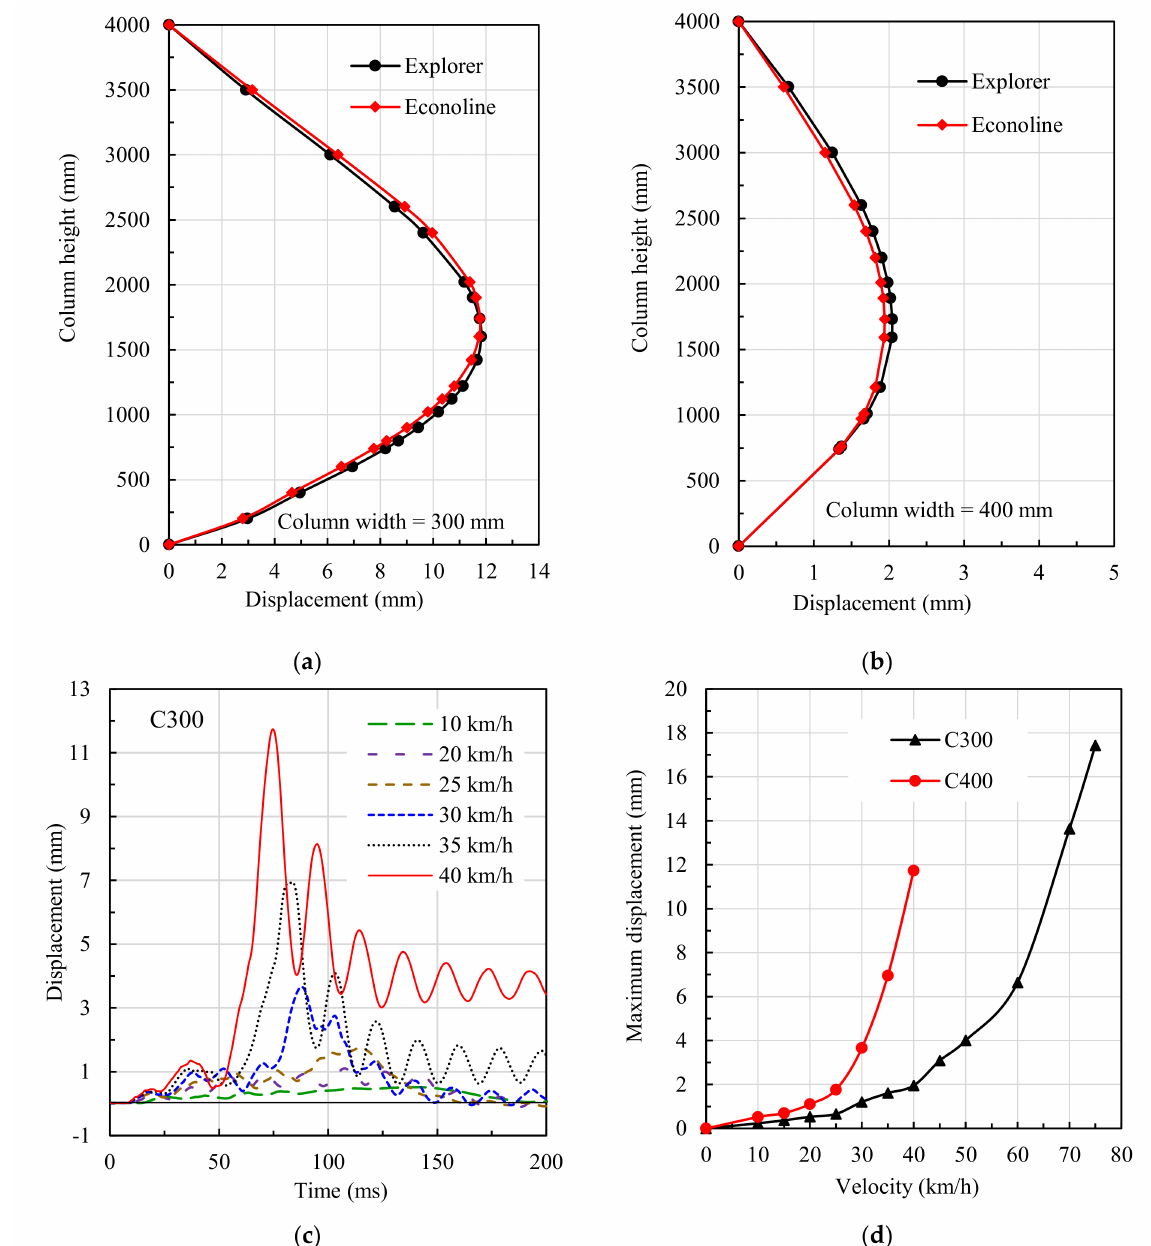
Figure 15. Deformation profile of column at maximum impact force (V = 40 km/h): ( a ) column size 300 × 300 mm; ( b ) column size 400 × 400 mm; ( c ) variation in column displacement history with car impact velocity; ( d ) effect of car (Econoline) impact velocity on the maximum displacement of